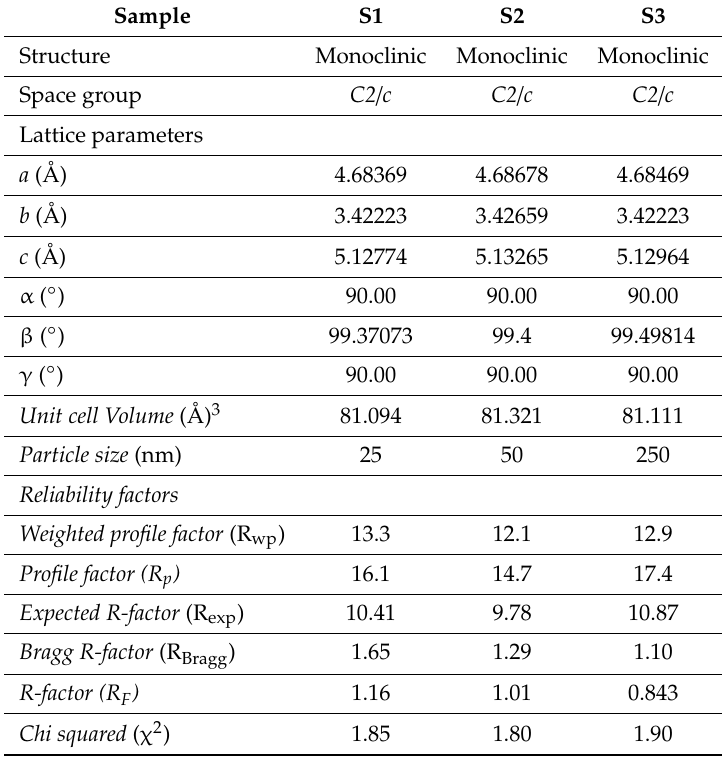
Table 1. Summary of the structural parameters of CuONPs obtained from the Rietveld analysis of the XRD